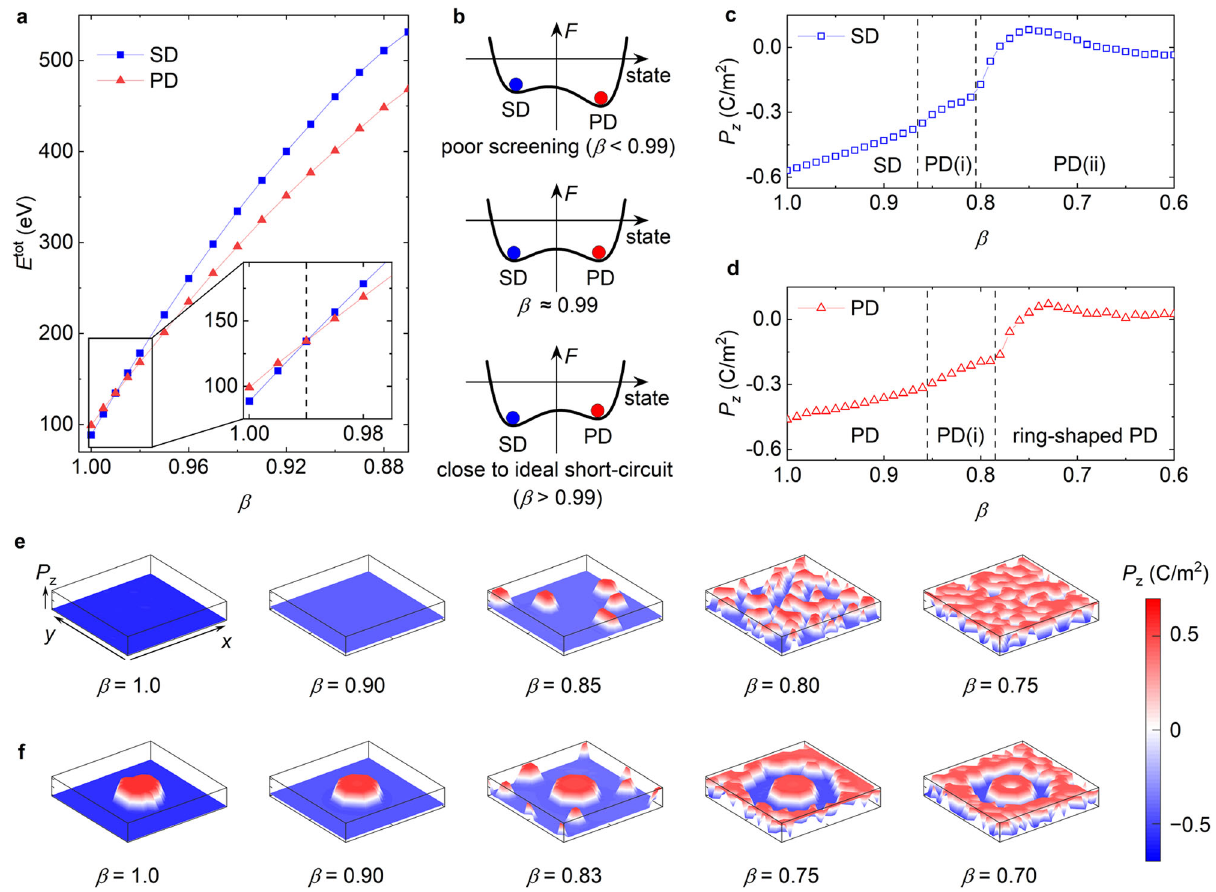
Fig. 2 Stability of SD and PD states under different surface screening conditions. a Total energy of ferroelectric thin fi lms with SD state (blue cubes and solid line) and PD state with a reversed domain r 0 = 4 a 0 (red triangles and solid line) as a function of surface screening factor β . b Schematics of the energy landscape of the two states under different surface screening conditions. c , d β dependence of the total polarization of the ferroelectric thin fi lms initialized to be a SD state (blue cubes and solid line) and a PD state with a reversed domain r 0 = 4 a 0 (red triangles and solid line). e , f Evolution of the equilibrium domain patterns in ferroelectric thin fi lms initialized to be a SD state (top) and a PD state with a reversed domain r 0 = 4 a 0 (bottom) with the decrease of β